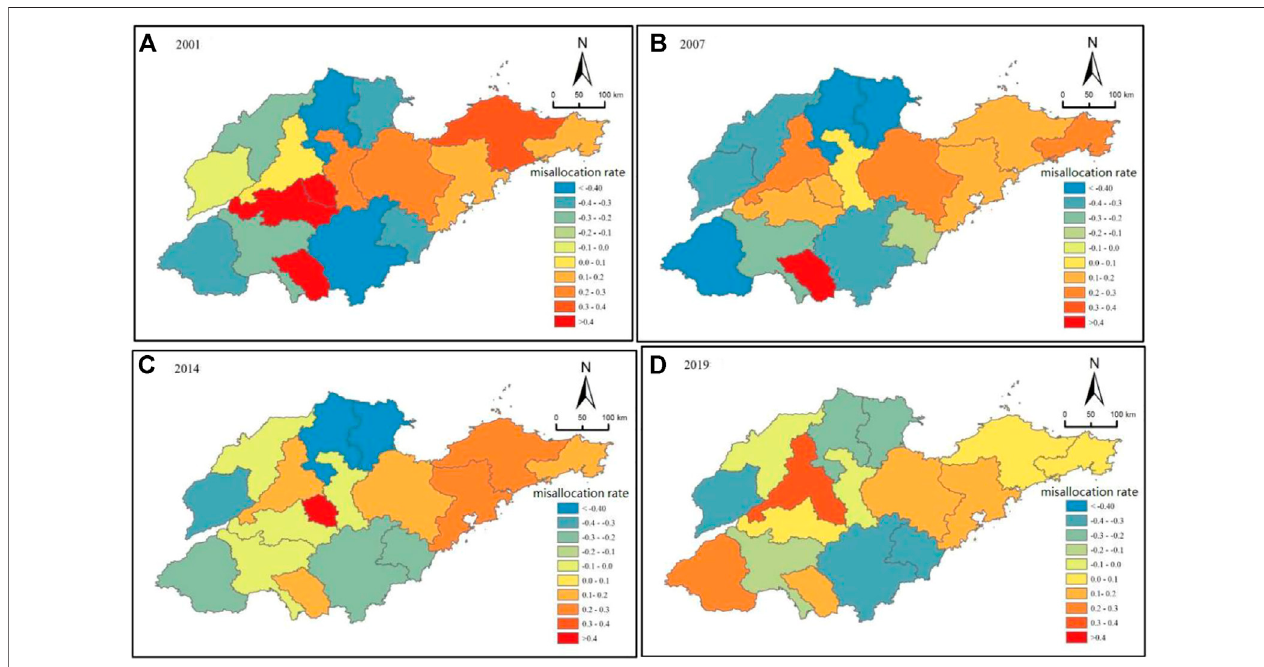
FIGURE 5 | Spatial pattern and evolution of the SMCL in Shandong province between 2001 and 2019. (A) 2001; (B) 2007; (C) 2014; (5) 2019. Note: This fi gure shows only the results of 4 years, and the others can be obtained by contacting the correspondence author.